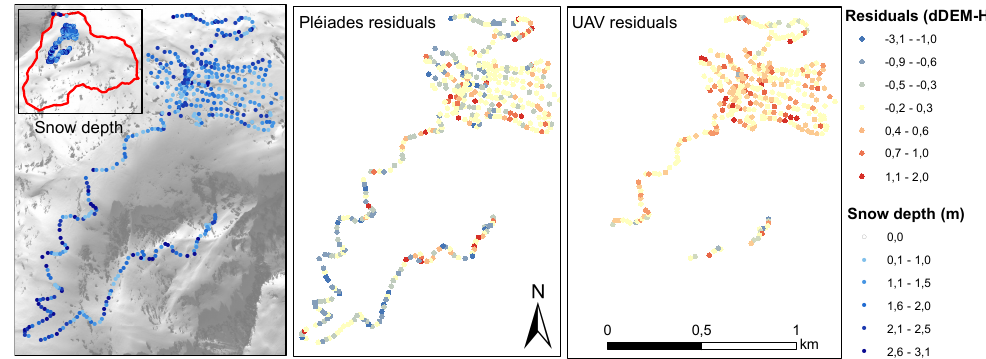
Figure 8. Left: map of snow depth sampling over the Pléiades winter orthoimage. Middle: map of 2m Pléiades residuals R (cid:49)Z . Right: map of 2m UAV residuals R (cid:49)Z .